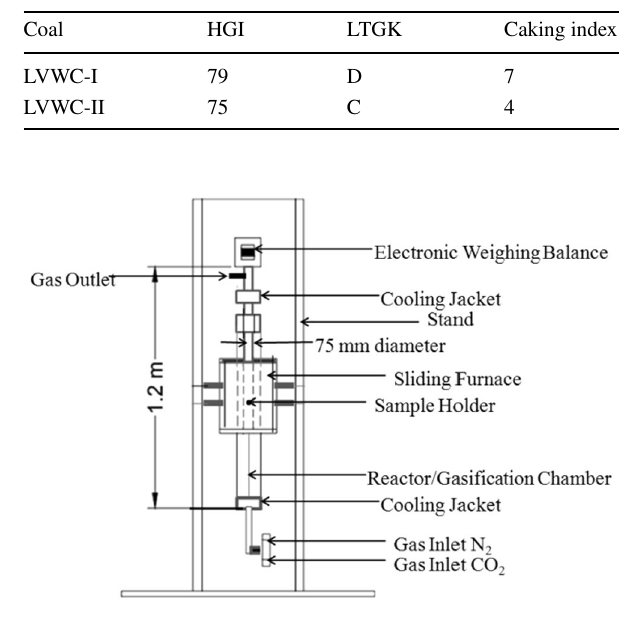
Table 4 Fractional conversion versus residence time for LVWC